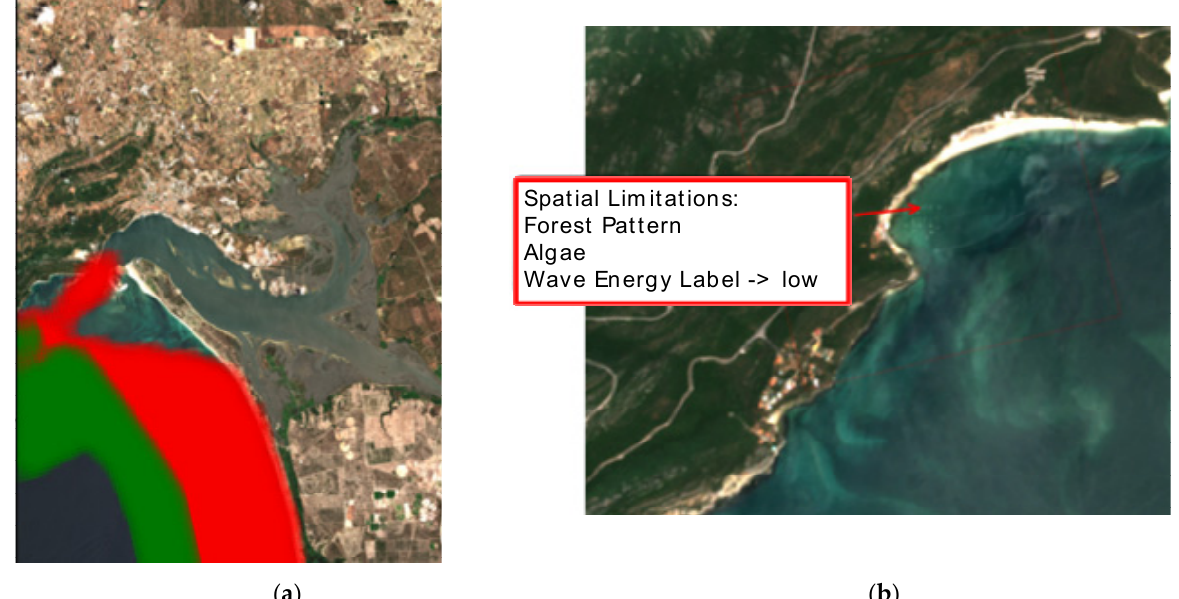
Figure 15. ( a ) Suitability map—Neural Network Predictions; ( b ) zoom to observe Multilabel Classification results.